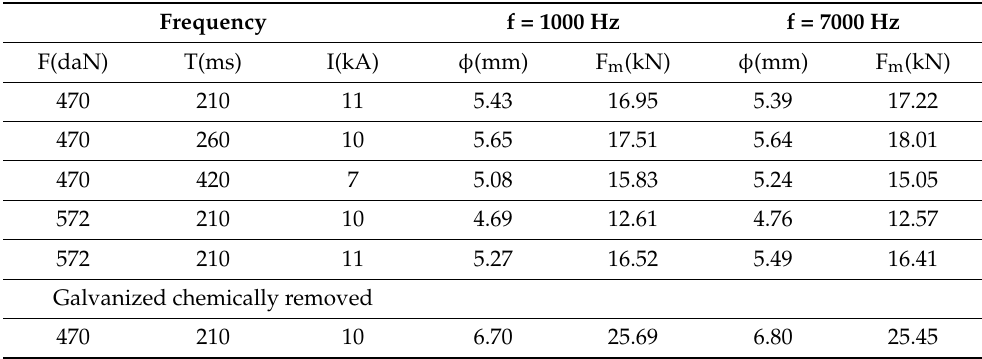
Table 6. Justification of the F m criterion for the weldability